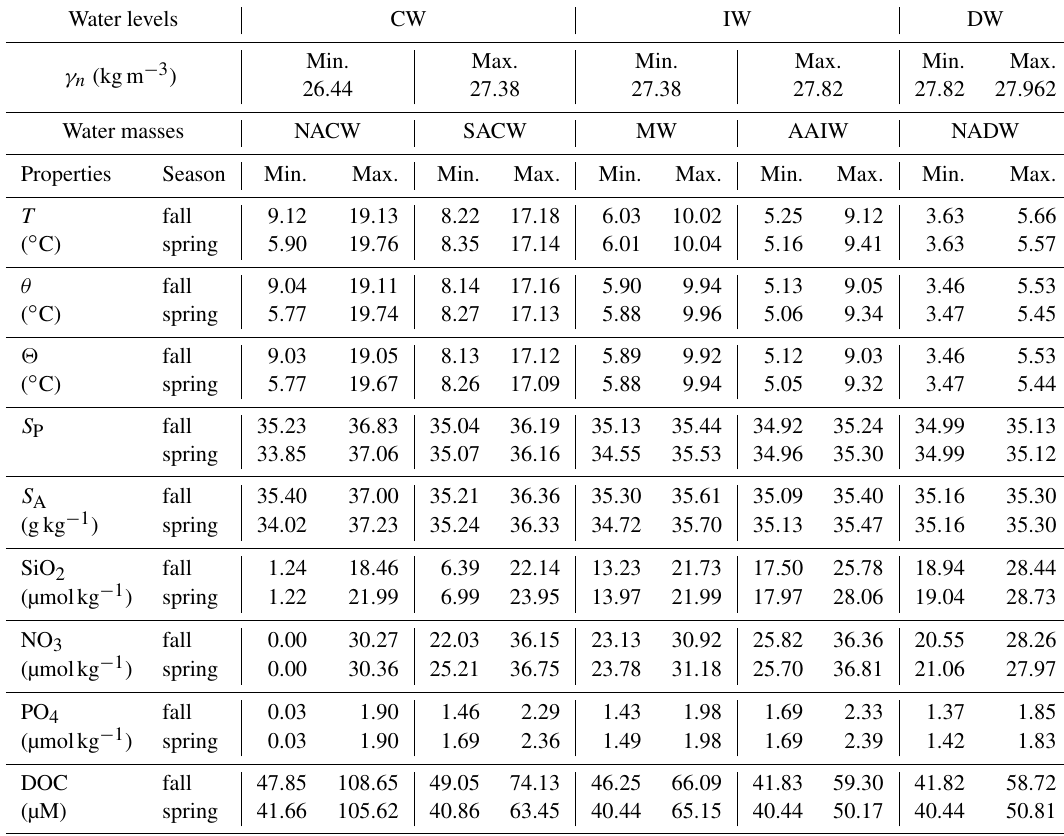
Table 2. Summary of water levels (CW, IW and DW) with their isoneutral limits and their water mass properties for both seasons from the sea surface to 2000m. The properties extracted from observations are in situ temperature ( T ), potential temperature ( θ ), conservative temperature ( (cid:50) ), practical salinity ( S P ), absolute salinity ( S A ) and dissolved organic carbon (DOC). The INs extracted from GLORYS-BIO are silicates (SiO 2 ), nitrates (NO 3 ) and phosphates (PO 4 ). Water